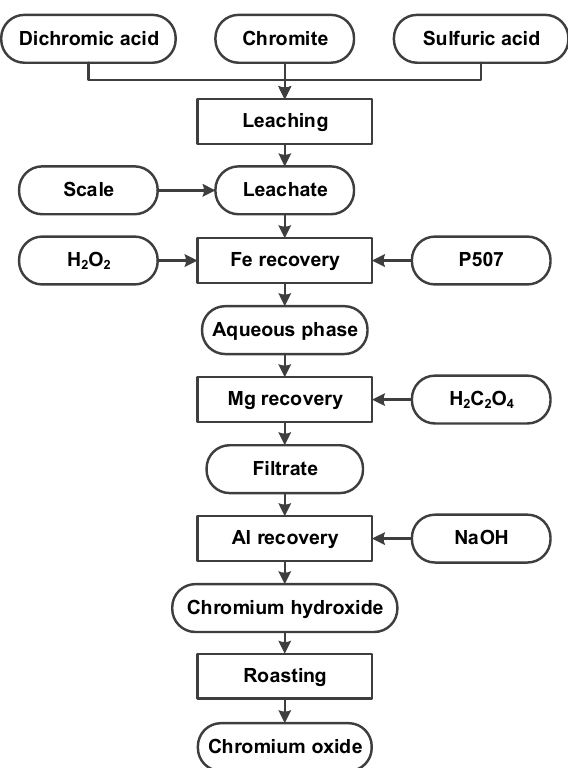
Figure 8. Flow sheet of the proposed process route for treating low-Fe(II) chromite.